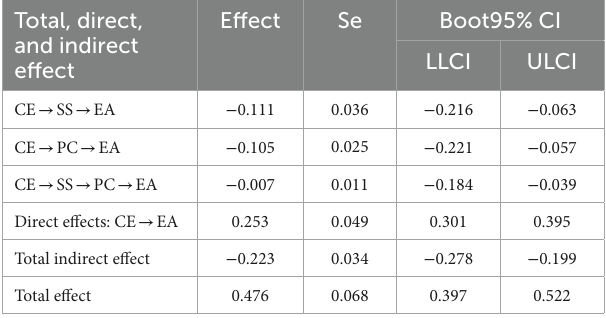
TABLE 2 Bootstrapping test result for chain mediating